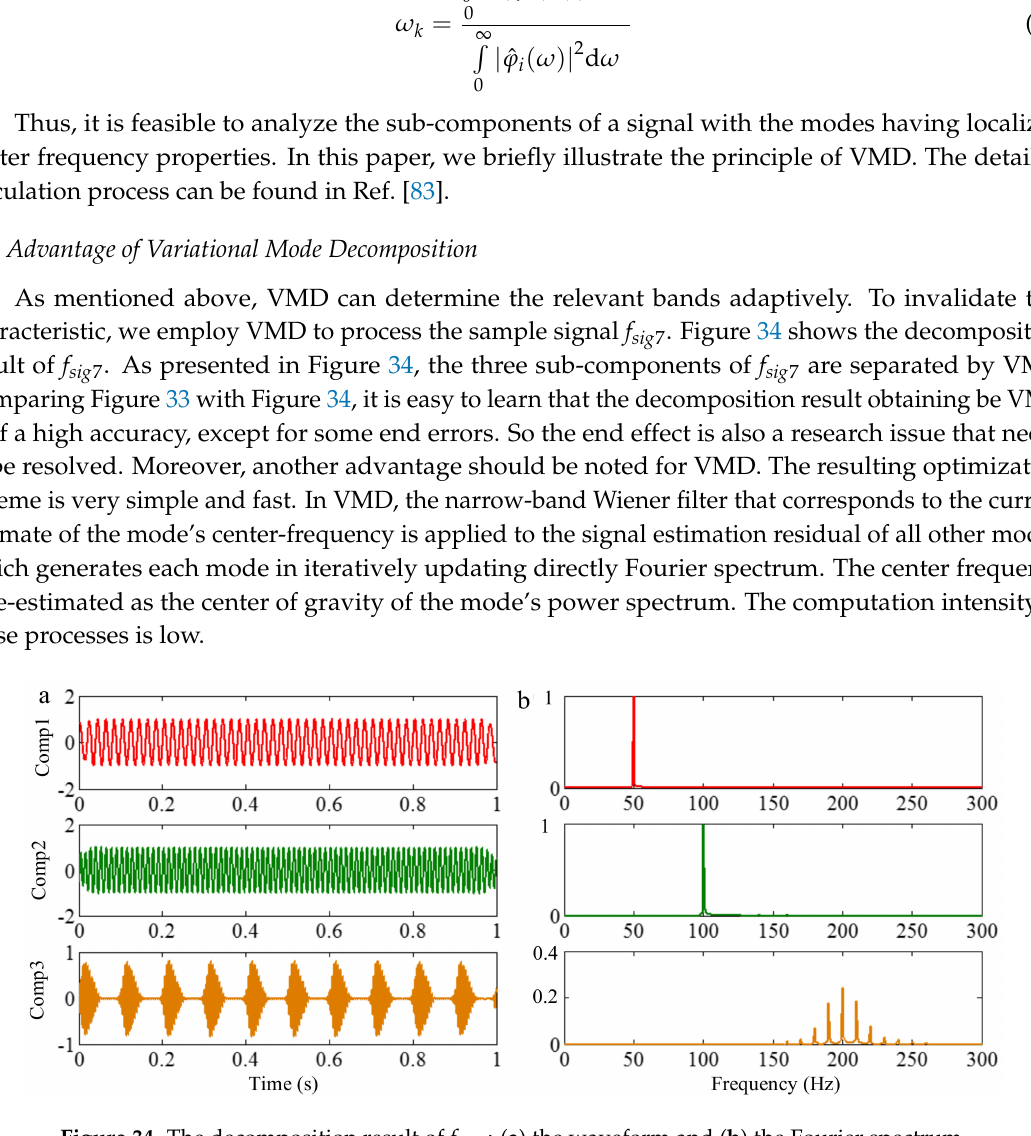
Figure 34. The decomposition result of f sig 7 : ( a ) the waveform and ( b ) the Fourier